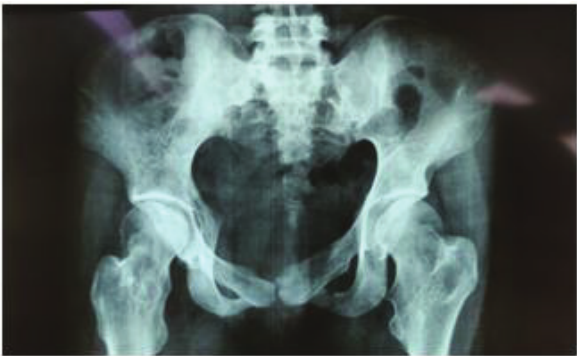
Fig-B: X-ray PELVIS showing multiple Osteochondromas